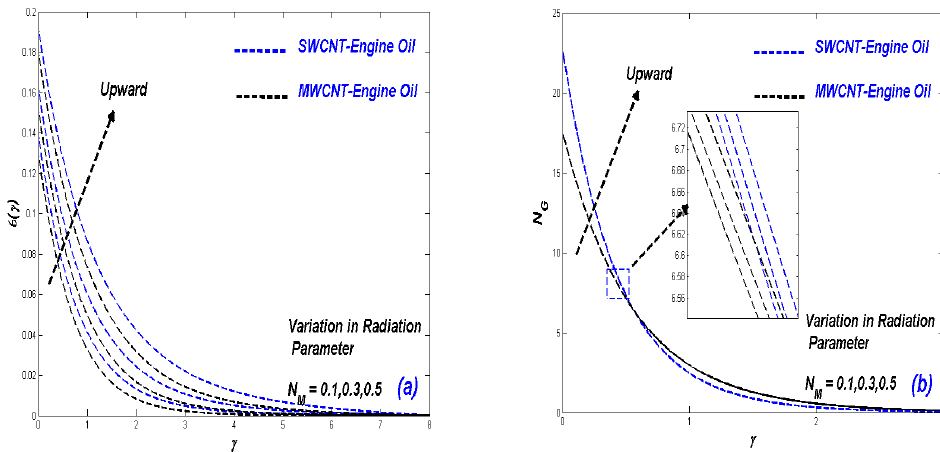
Figure 9. ( a ) Temperature change with N M ; ( b ) Entropy change with N M .